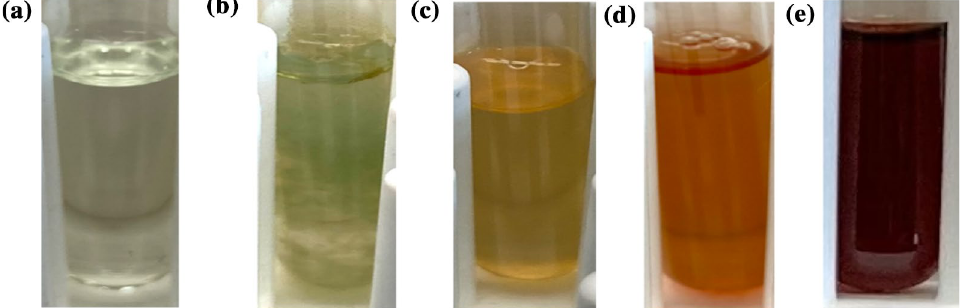
Fig. 2 Liquid portion (supernatant) of a 4-day reaction mixture of aged Rhodes steel wool and DW vinegar: a colorless reaction solution not treated further; b with added NaOH (enough to neutralize half of the acetic acid in the vinegar), green precipitates of presumably ferrous hydroxide and green rust I form; c with added NaOH, shaken, and allowed to stand for 2 min, ferric ion forms, producing a yellow–orange color; d with added NaOH, shaken, and some Fe(III) chloride added, the dark red complex is likely formed. e Dark red–brown liquid portion (supernatant) of a 14-day